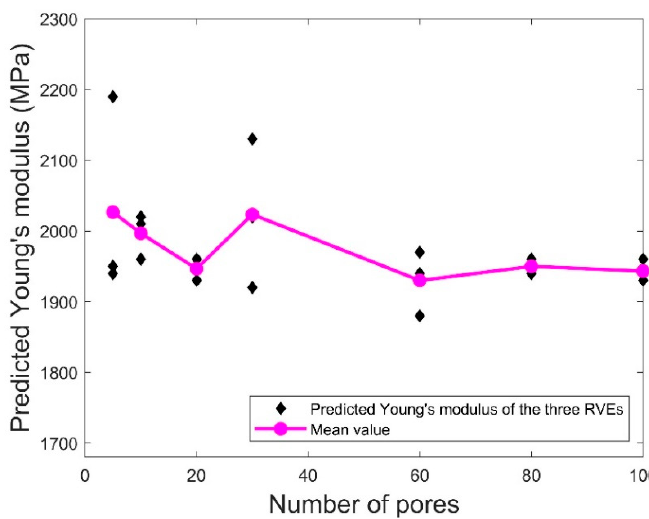
Figure 12. Scatter plots of the predicted Young’s modulus for porosity = 20%. Also included are the mean values of the predicted Young’s modulus of the three RVEs.